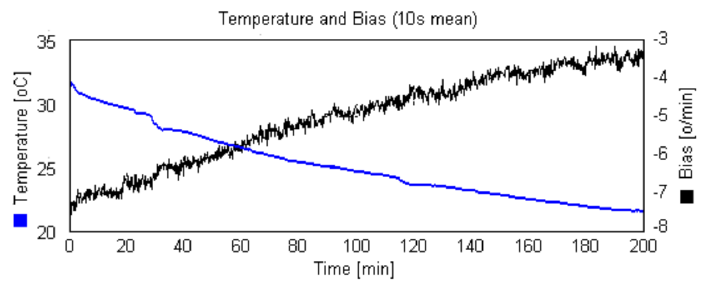
Figure 18. Relation bias × temperature of a tested gyroscope